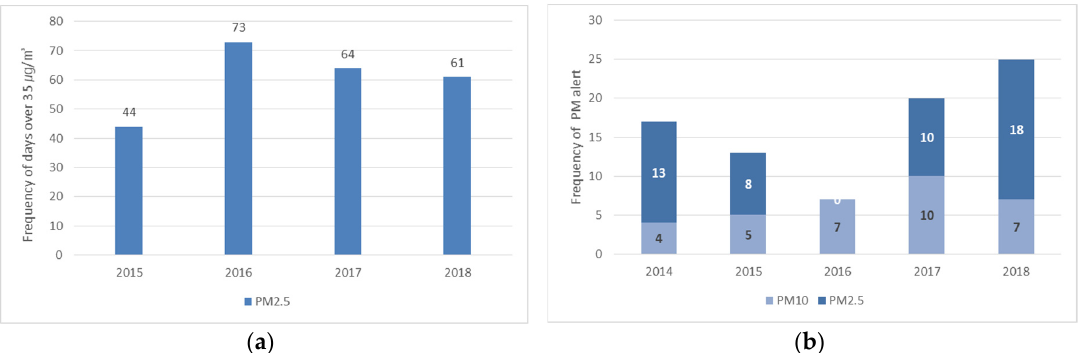
Figure 2. High PM concentration days: (a) days exceeding a PM 2.5 of 35 ㎍ / ㎥ on average for 24 hours; (b) PM and ultra-PM warning and alarm days (Source: Seoul Atmospheric Environment Information).